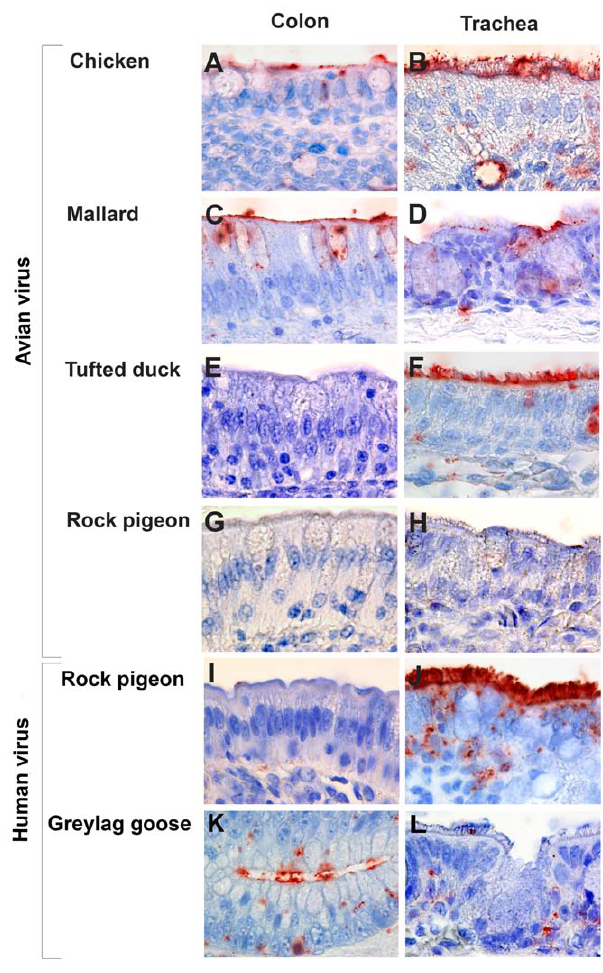
Figure 1. Colon and trachea sections from selected wild bird species showing that the pattern of attachment of avian and human influenza viruses varies between bird species. (a) chicken colon with avian virus; (b) chicken trachea with avian virus; (c) mallard colon with avian virus; (d) mallard trachea with avian virus; (e) tufted duck colon with avian virus; (f) tufted duck trachea with avian virus; (g) rock pigeon colon with avian virus; (h) rock pigeon trachea with avian virus; (i) rock pigeon colon with human virus; (j) rock pigeon trachea with human virus; (k) greylag goose colon crypt with human virus; (l) greylag goose trachea with human virus.